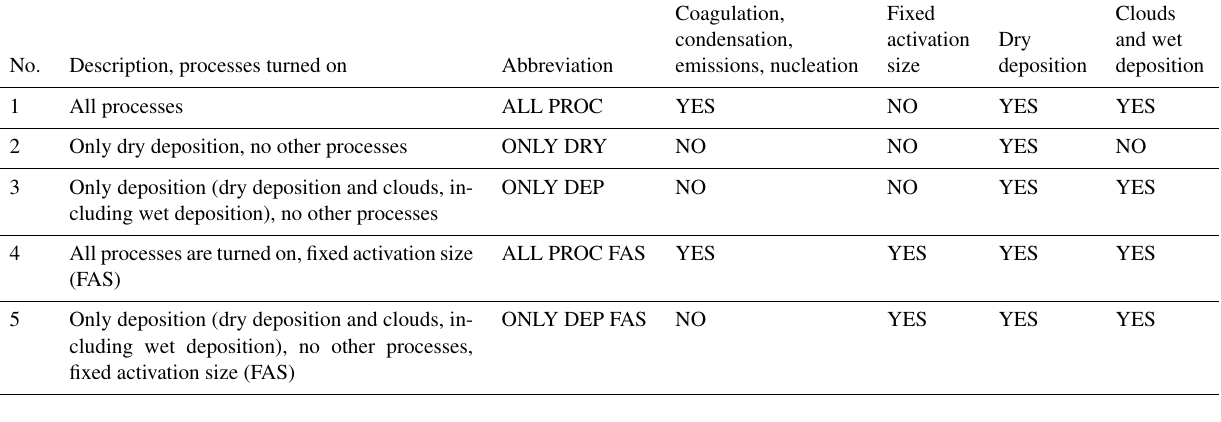
Table 2. The different experiments.